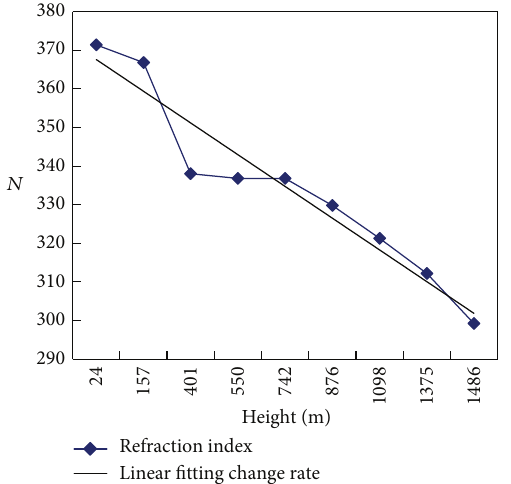
Figure 1: Linear-fit change rate of the refraction index ( 𝑁 ) under (B) conditions.